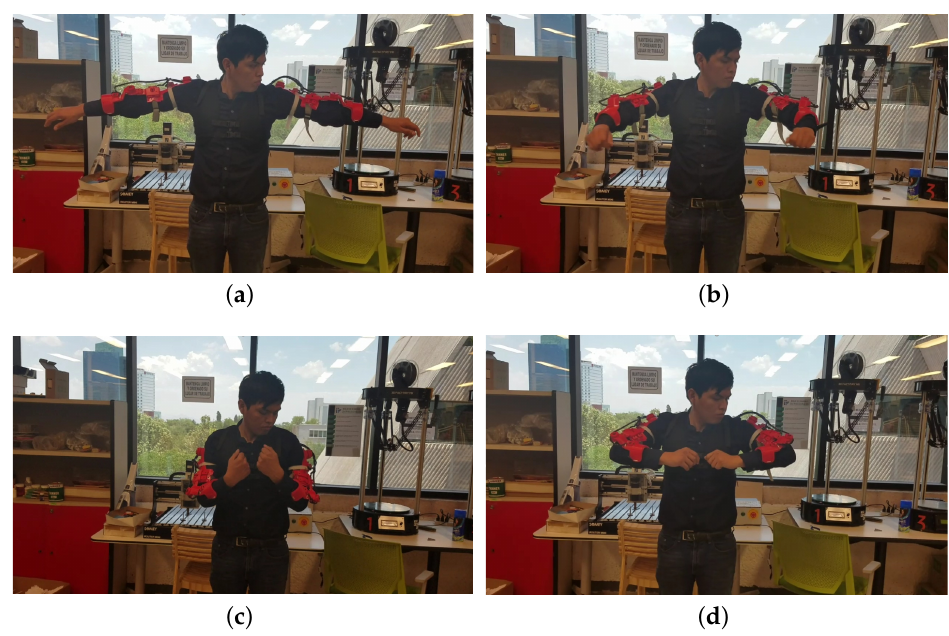
Figure 11. Experimental human workspace for the upper limb. ( a ) Movement of the first joint ( γ 1 ) between the ranges of < − 180 ◦ , 180 ◦ > . ( b ) Movement of the second joint ( γ 2 ) between the ranges of < − 90 ◦ , 90 ◦ > . ( c ) Movement of the third joint ( γ 3 ) between the ranges of < − 90 ◦ , 90 ◦ > . ( d ) Movement of the fourth joint ( γ 4 ) between the ranges of < − 180 ◦ , 180 ◦ > .